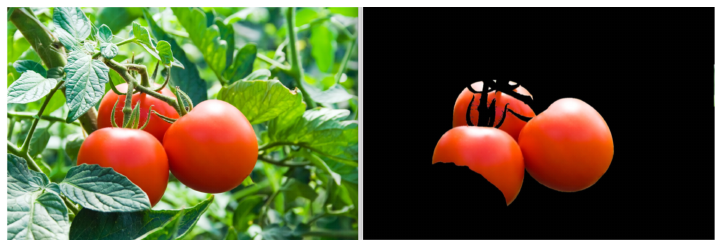
Figure 10. Original image and reference pattern, painted ideally.